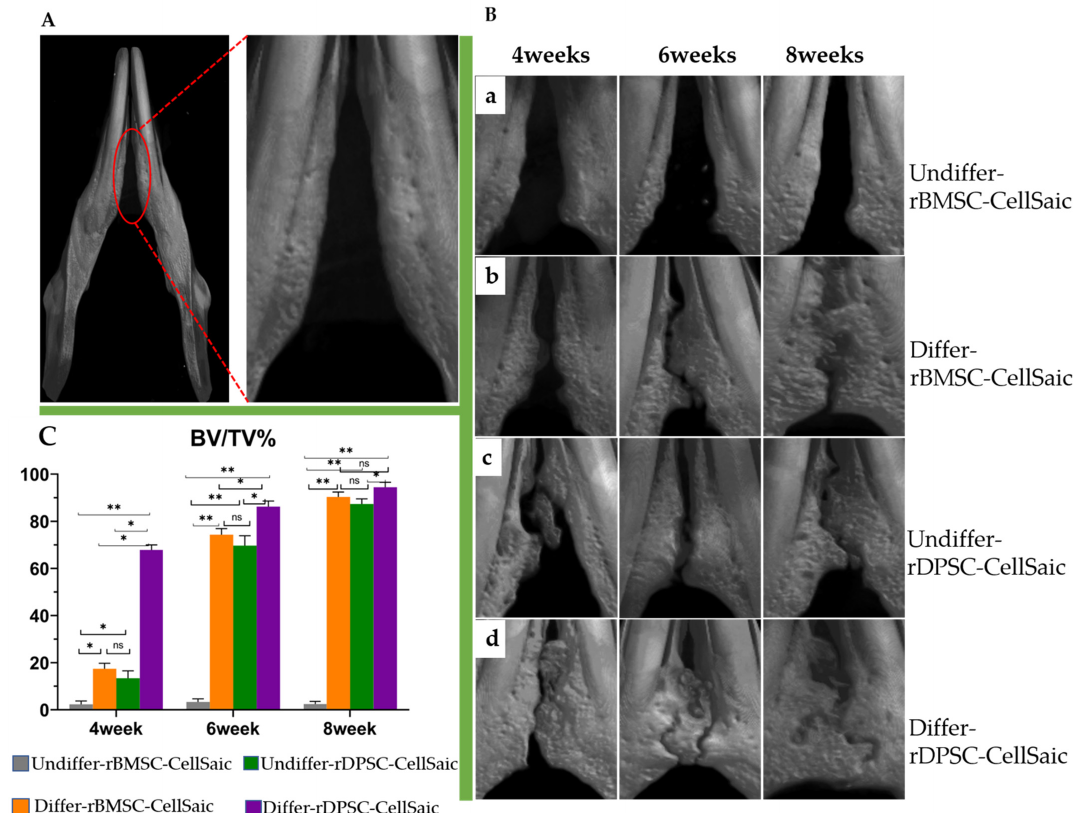
Figure 11. Osteogenesis after 4, 6, and 8 weeks using microcomputed tomography and analysis of bone volume/tissue volume. ( A ) Blank control group 4 weeks after the operation. ( B ) Osteogenesis at 4, 6, and 8 weeks; ( a ) rBMSC-CellSaic undifferentiated group; ( b ) rBMSC-CellSaic bone differentiated group; ( c ) rDPSC-CellSaic undifferentiation group; ( d ) rDPSC-CellSaic differentiation group. ( C ) Analysis of bone volume/tissue volume (%). (* p < 0.05, ** p < 0.001, ns: no significance).